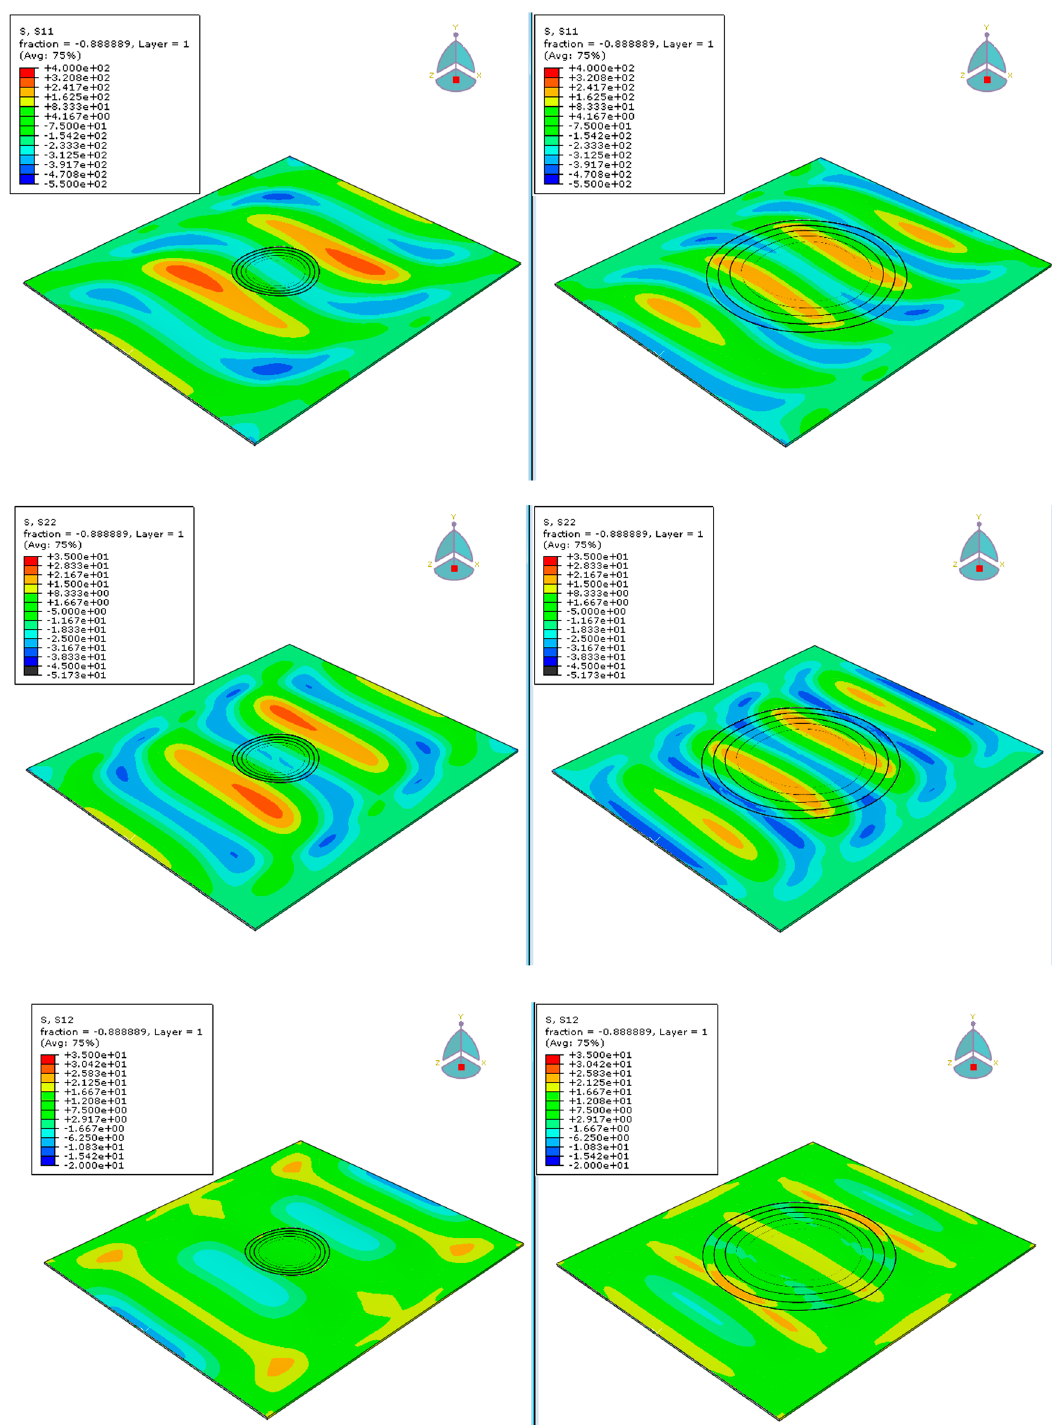
Figure9. BreakdownstrainsS11, S22andS12forrepairwith20( leftcolumn )and50( rightcolumn Figure 9. Breakdown strains S11, S22 and S12 for repair with 20 ( left column ) and 50 ( right column ) ratio.